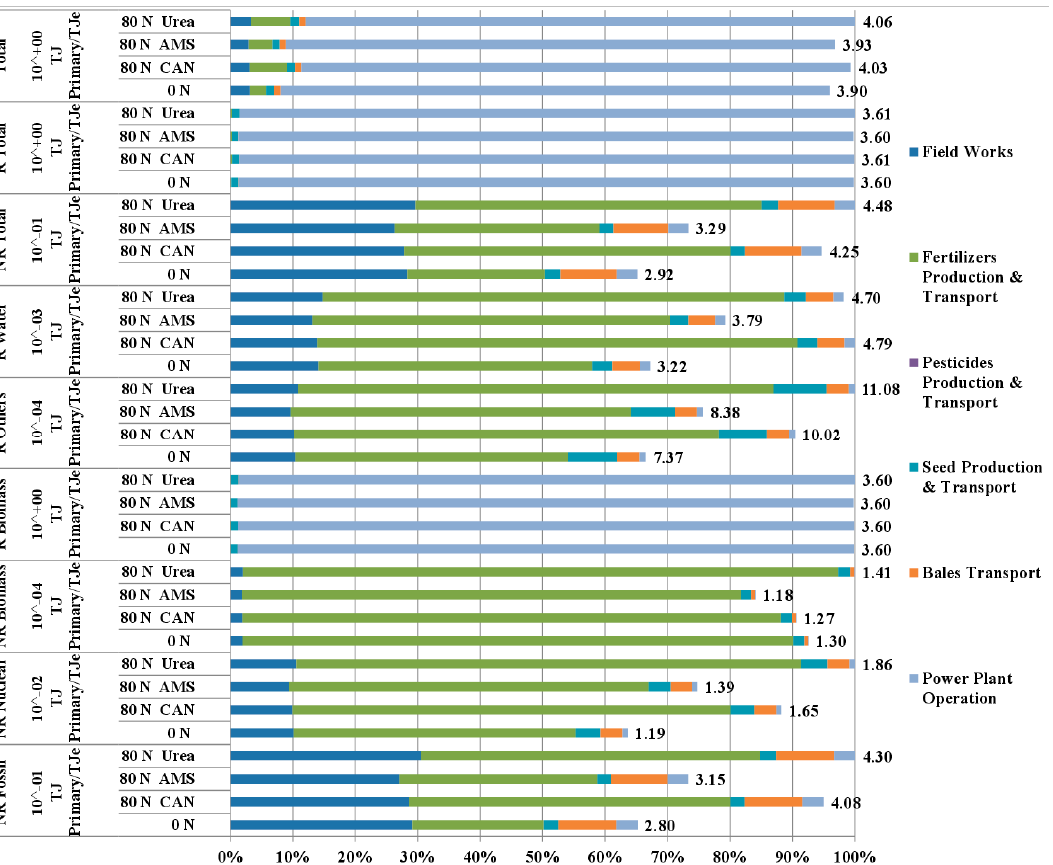
Figure A1. Types of energy consumed by phases considered in the life cycle of the rye energy crops grown under four different fertilizer regimes when producing 1 TJe. R: renewable energy; NR: non-renewable energy; R: Others: wind, solar, geothermal renewable energies among others, AMS: ammonium sulphate, CAN: calcium ammonium nitrate. Nitrogen fertilizers aplication rates at the y -axis are in kg/ha. The percentages of the x -axis represent the relative contribution of each one of the four fertilizer alternatives studied with respect to the one which produced the highest impacts (100%).